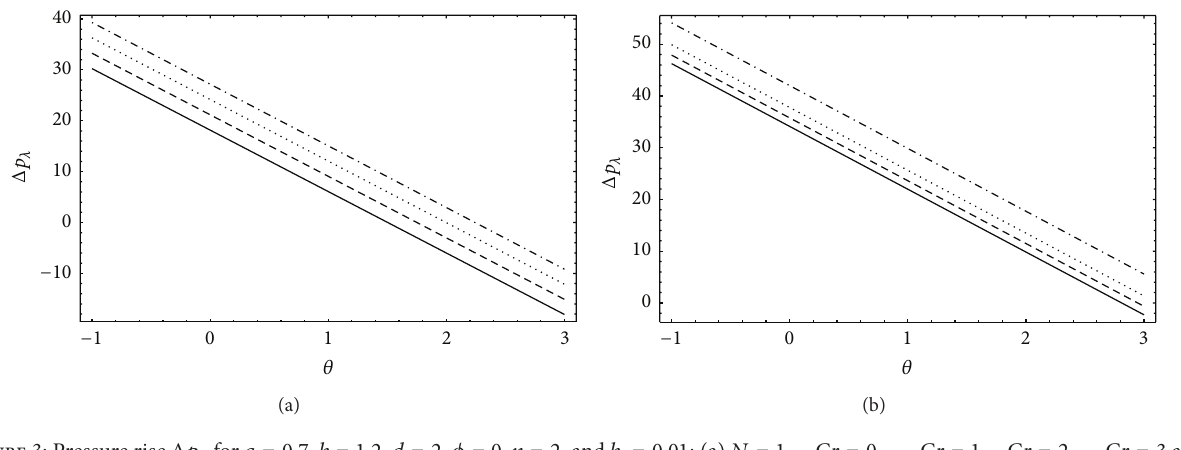
Figure 3: Pressure rise Δ𝑝 𝜆 for 𝑎 = 0.7 , 𝑏 = 1.2 , 𝑑 = 2 , 𝜙 = 0 , 𝑛 = 2 , and 𝑏 𝑠 = 0.01 : (a) 𝑁 = 1 , 𝑁 = 0.1 , 𝑁 = 0.3 , 𝑁 = 0.4 , and 𝑁 = 0.5 . (b) Gr = 5 , ... . . . — –––